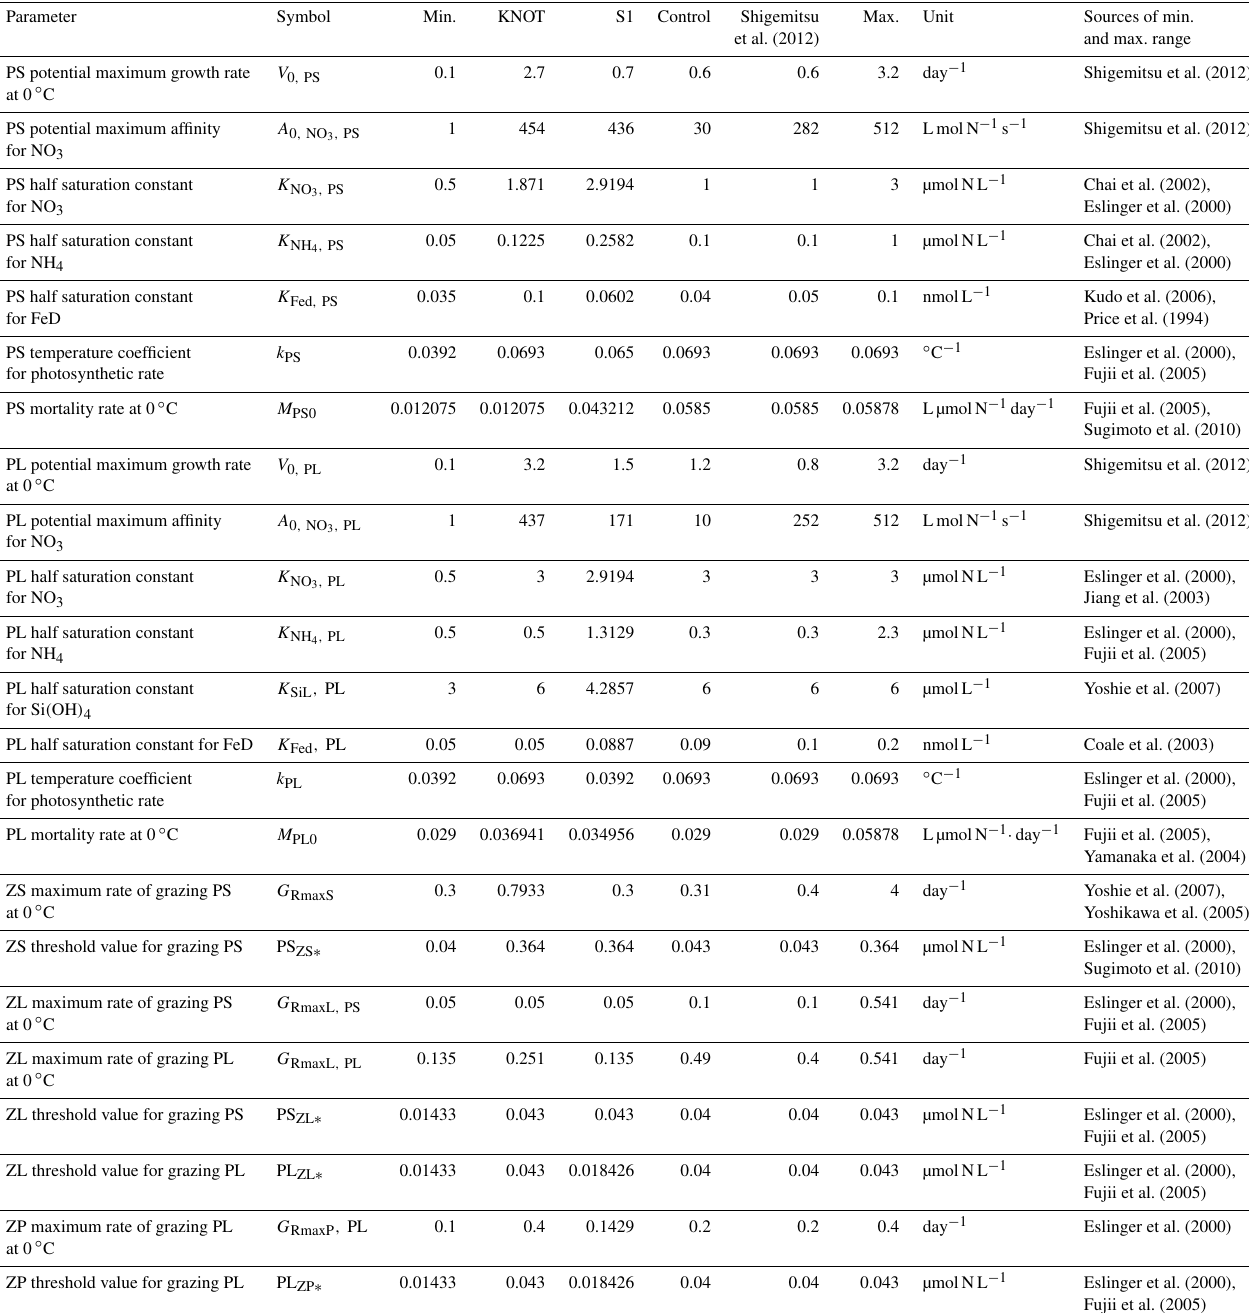
Table 2. NSI-MEM physiological parameters estimated by the µ -GA. Maximum and minimum values prescribe the upper and lower bounds of the parameter variations used in the previous studies. KNOT and S1 indicate optimal estimated values in the provinces of Fig. 1b while control values are not optimized parameter values, and the values of Shigemitsu et al. (2012) are the parameters of the previous